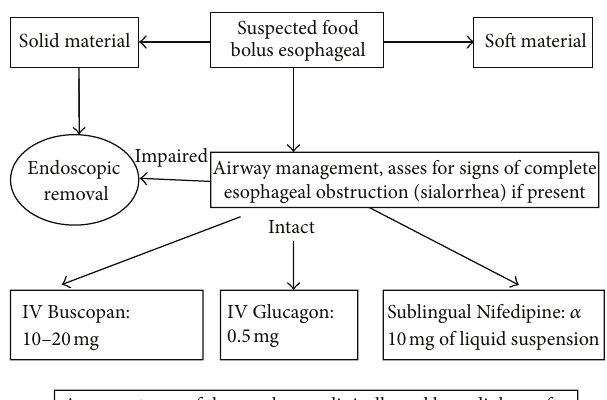
Figure 1: Suggested algorithm for management of suspected food bolus